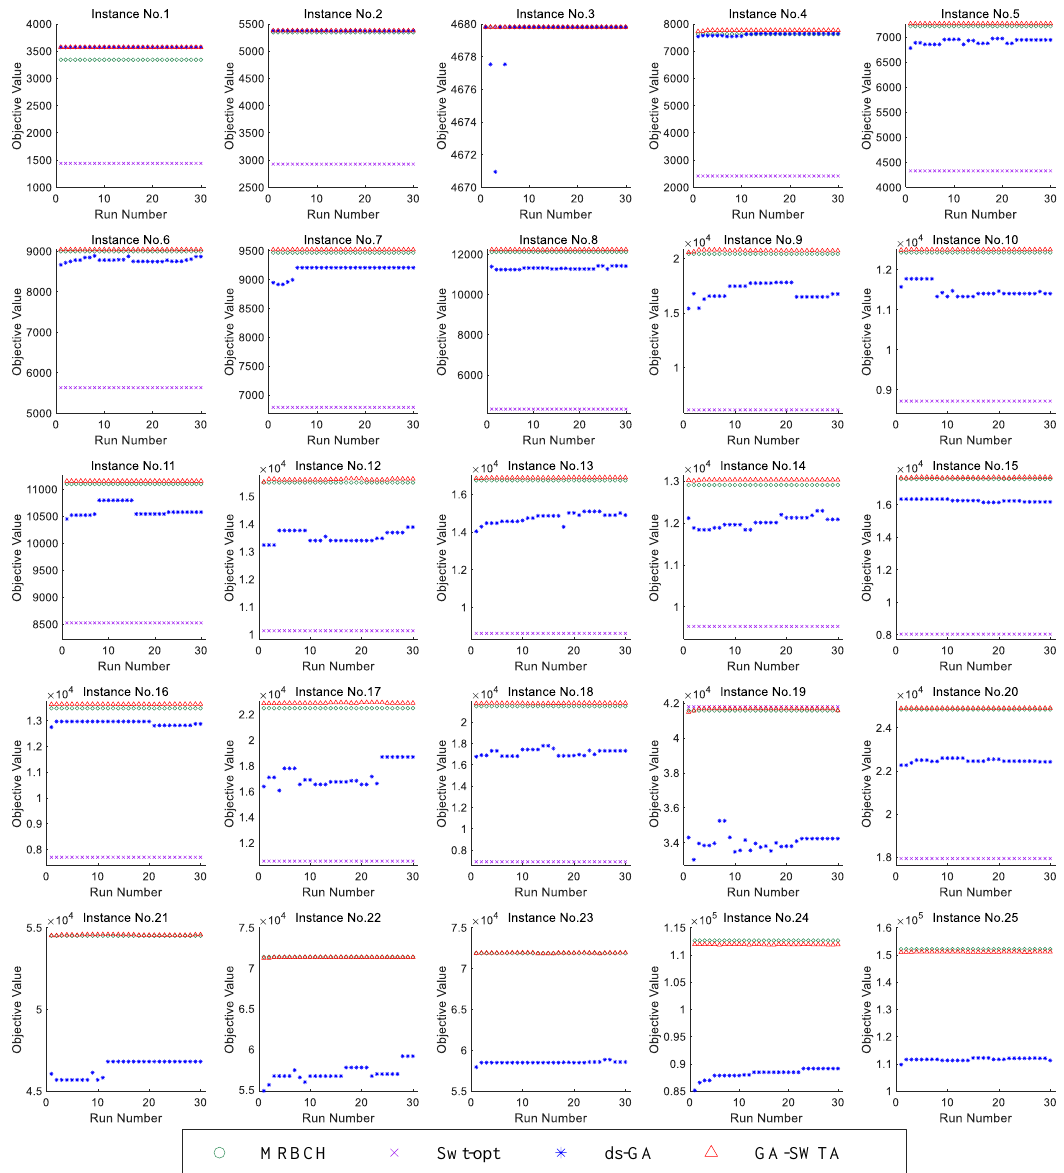
Figure 11. Comparison results of MRBCH, Swt-opt, ds-GA and GA-SWTA with respect to the objective